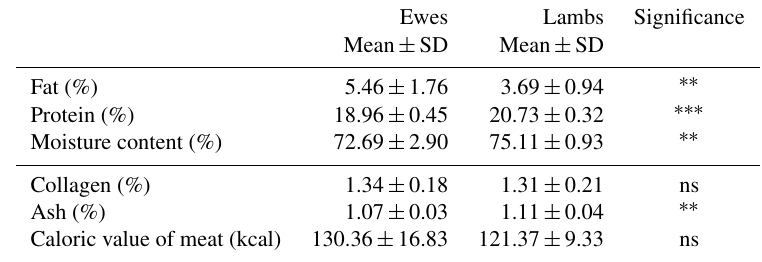
Table 3. Quality traits of ewe and lamb musculus biceps femoris meat.